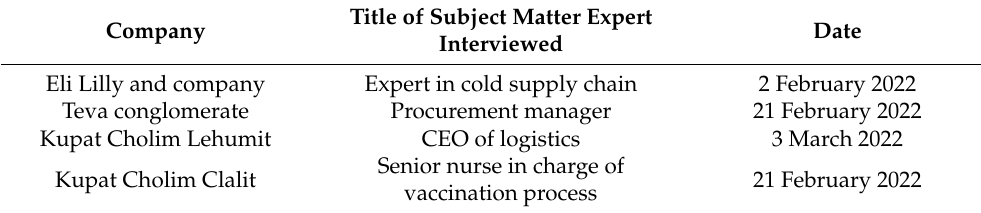
Table 1. List of